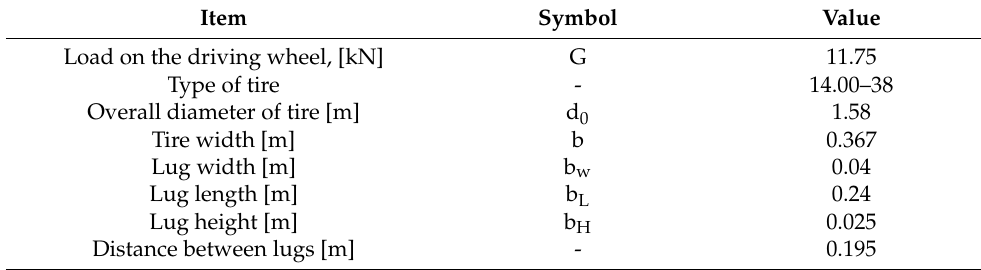
Table 1. Characteristics of the U-650 tractor and drive wheels.